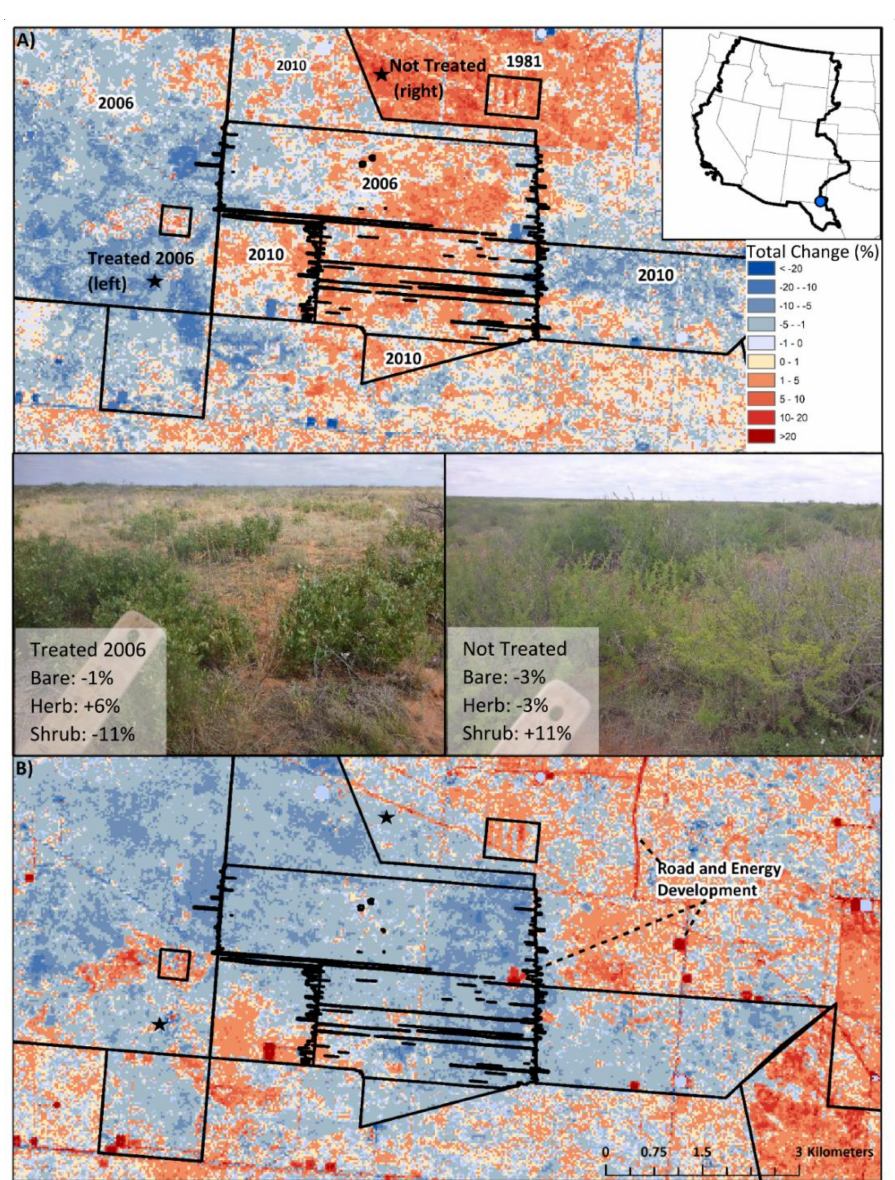
Figure 8. Component cover changes related to woody encroachment by honey mesquite, vegetation treatments, and energy development in southeast New Mexico. ( A ) Temporal slope of shrub cover from 1985 to 2018, with Bureau of Land Management (BLM) vegetation treatments (herbicide applications) outlined in black and year of treatment indicated. Inset map shows location of case study within the study area. Stars indicate the location of corresponding plot photos for a site treated with herbicide in 2006 and one without a treatment history, left and right, respectively. Photos include the fractional cover change from 1985 to 2018 in each plot. Photos taken on August 20, 2016, credit M. Rigge, ( B ) temporal slope of bare ground cover from 1985 to 2018. For A and B, refer to Figure 3 for interpretation of temporal slope